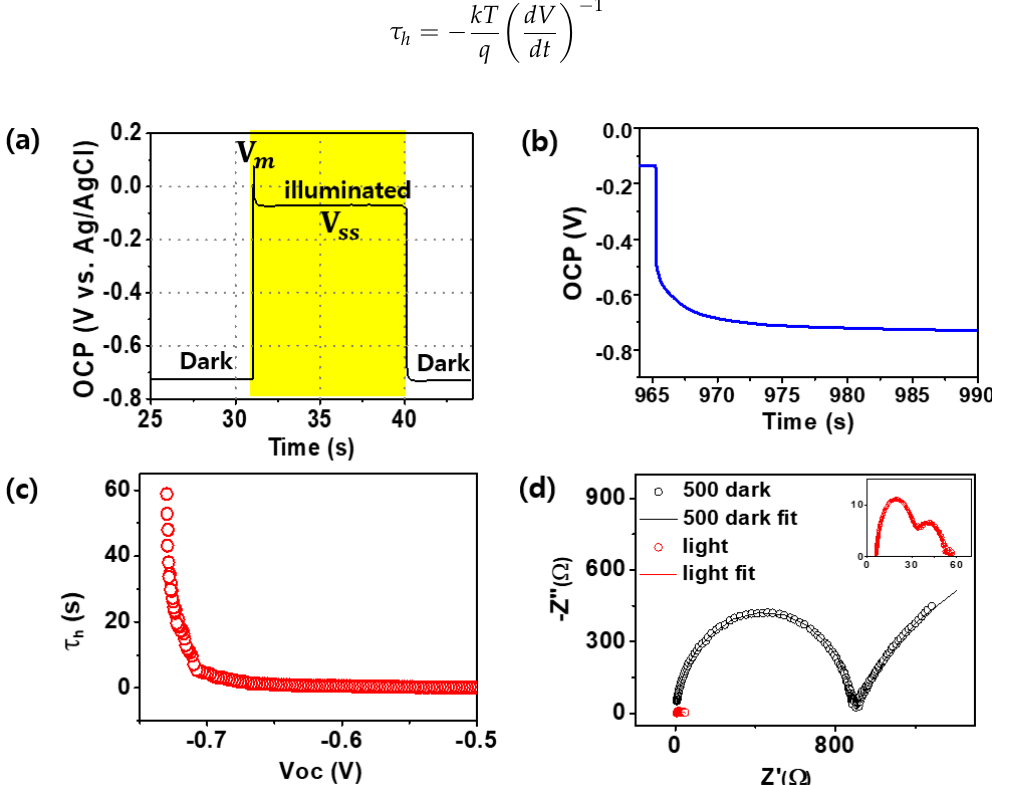
Figure 6. ( a ) OCP measurements of the 500 ALD-cycled MoS 2 /Si photocathode. ( b ) OCP decay after illumination for 20 min. The photocathode was illuminated at 100 mWcm − 2 before measuring the OCP decay. ( c ) Carrier lifetime dependence on OCP of the photocathode. ( d ) Electrochemical impedance spectroscopy (EIS) measurement of p -Si/SiO x /MoS 2 of 500-ALD-cycle photocathode under dark (black) and under illuminated condition (red, inserted).